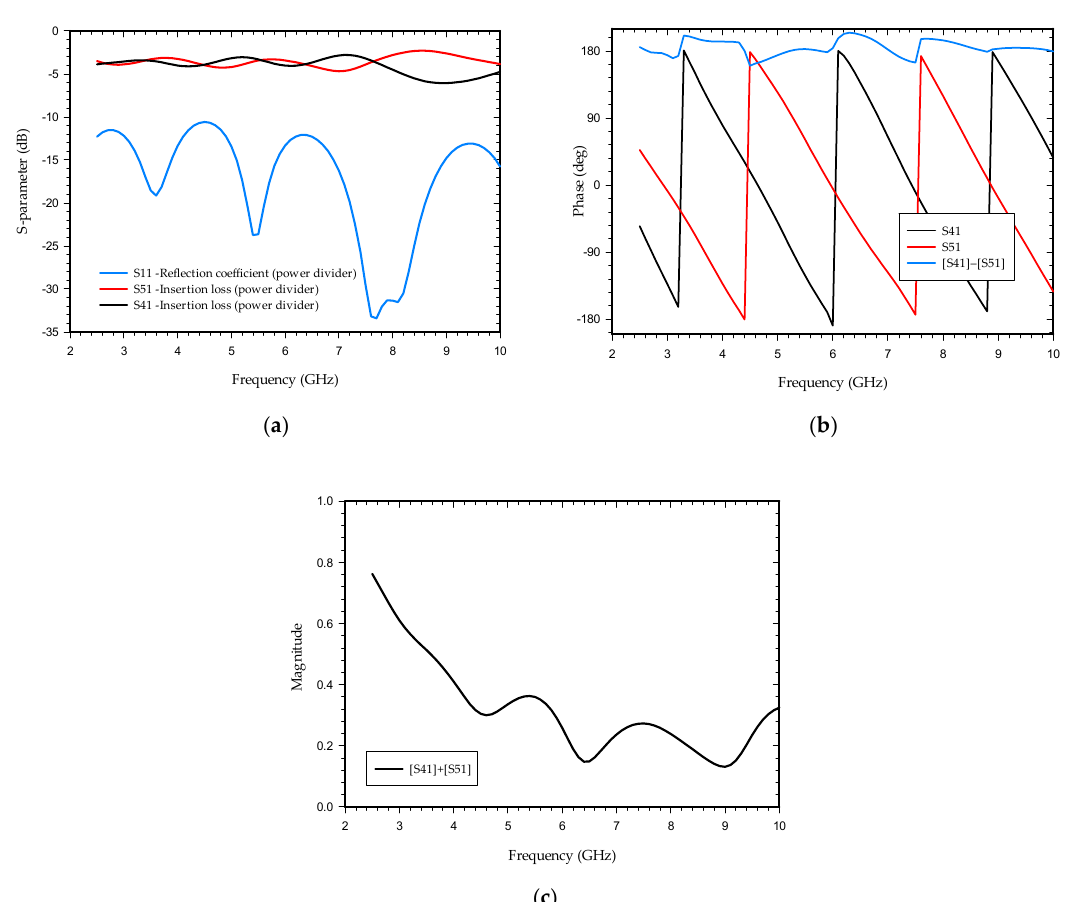
Figure 3. S-parameter with phase and magnitude of the power divider with phase-shifter at one of the arms: ( a ) output port return loss; ( b ) output port phase, and ( c ) magnitude.